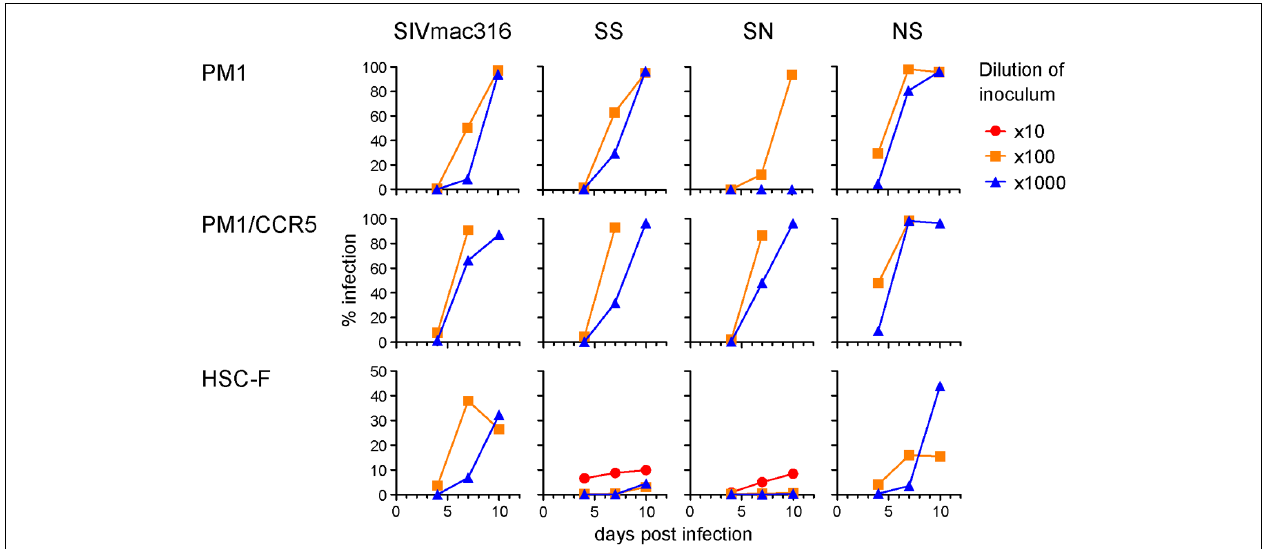
T cells were infected with the various dilutions of SIVmac316, SS, SN, and NS. Infected cells were detected using flow cytometry after intracellular staining by B450 (anti-p27